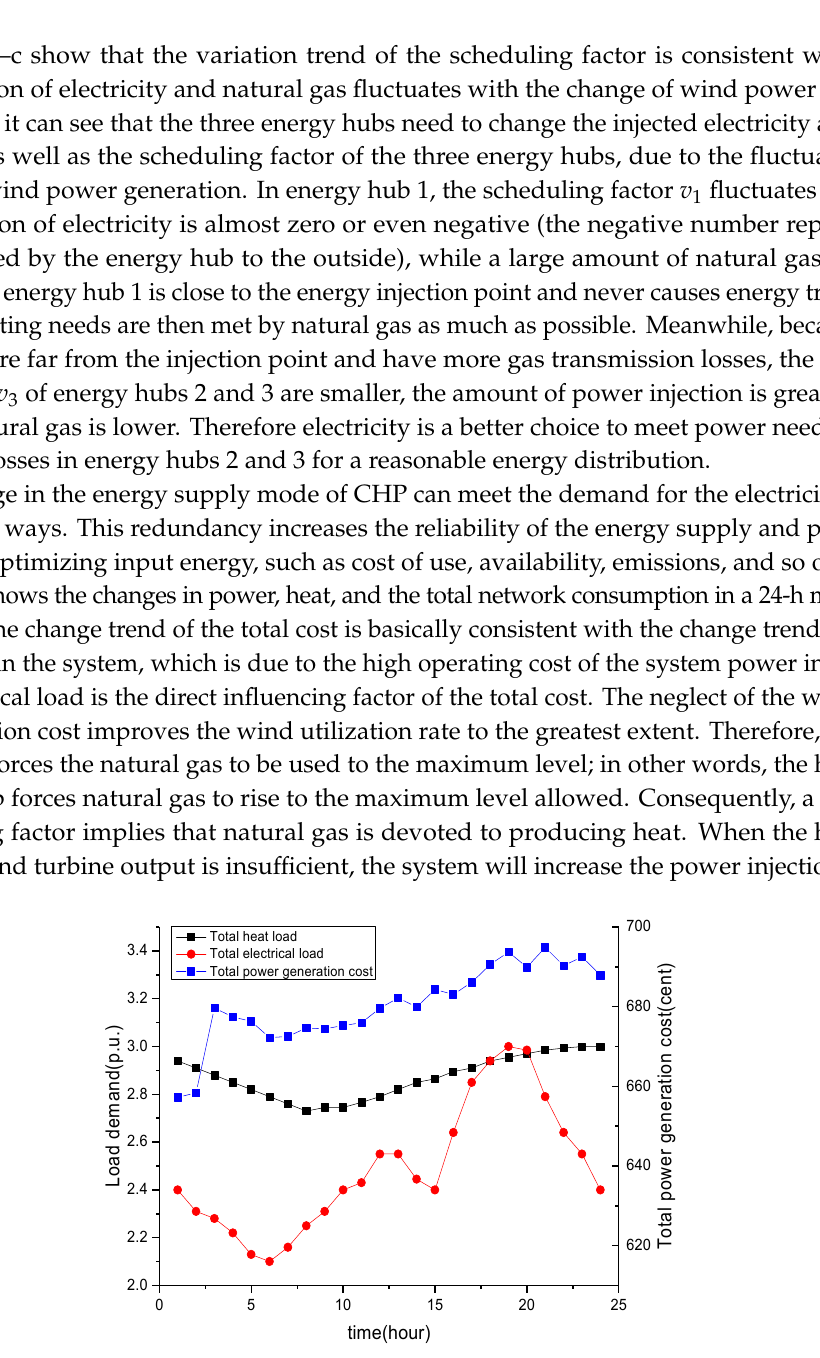
Figure 6. System variables of three energy hubs’ change in 24 h: ( a ) Scheduling factor; ( b ) input electricity; ( c ) input natural gas.